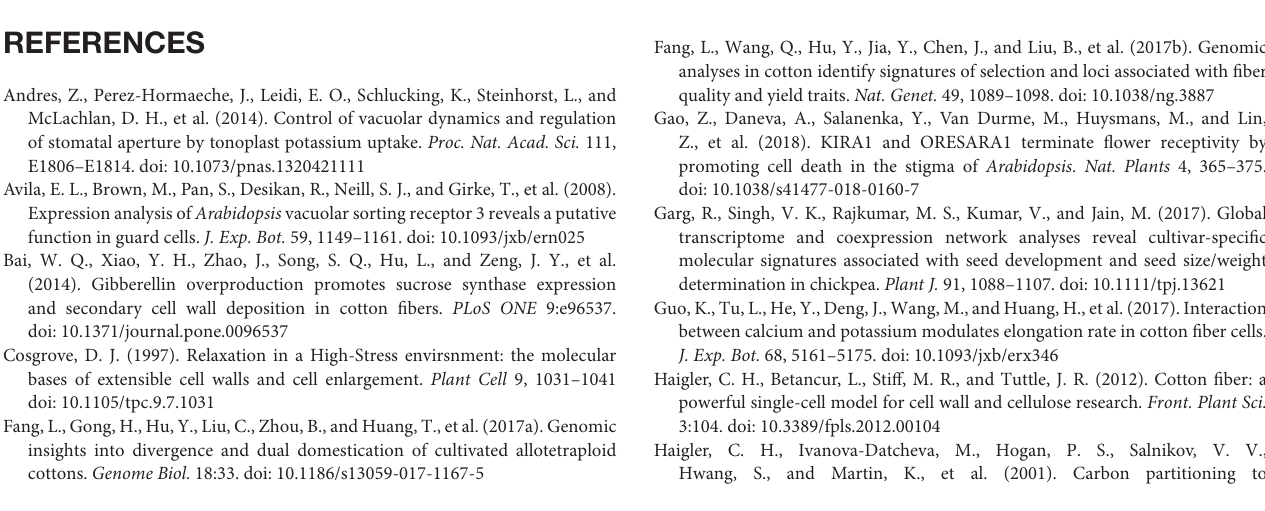
Supplementary Figure 10 | Expression pattern of candidate genes in SL15 during different fiber development periods. Blue and black numbers respectively count genes in the substituted chromosome segment and DEGs in each cluster. Supplementary Figure 11 | Transcriptome correlation and clustering analyses. (A) Spearman correlation coefficient (SCC) analysis of LMY22 and SL15 transcriptomes across fiber development periods. (B) Principal component analysis (PCA) plot showing clustering in LMY22 and SL15 transcriptomes during four fiber development periods. Supplementary Table 1 | List of primers used in qRT-PCR verification. Supplementary Table 2 | Summary of transcriptome data for all 16 samples. Supplementary Table 3 | GO annotations for genes differentially-expressed between LMY22 and SL15 at 15 DPA. Supplementary Table 4 | GO annotations for genes differentially-expressed between LMY22 and SL15 at 20 DPA. Supplementary Table 5 | GO annotations for genes differentially-expressed between LMY22 and SL15 at 25 DPA. Supplementary Table 6 | KEGG annotations for genes differentially-expressed between LMY22 and SL15. Supplementary Table 7 | Genes in the chromosomal segment substituted in SL15. Supplementary Table 8 | Information of promoter region SNP mutations of candidate genes. Supplementary Table 9 | Summary of the eight SL15 DEG